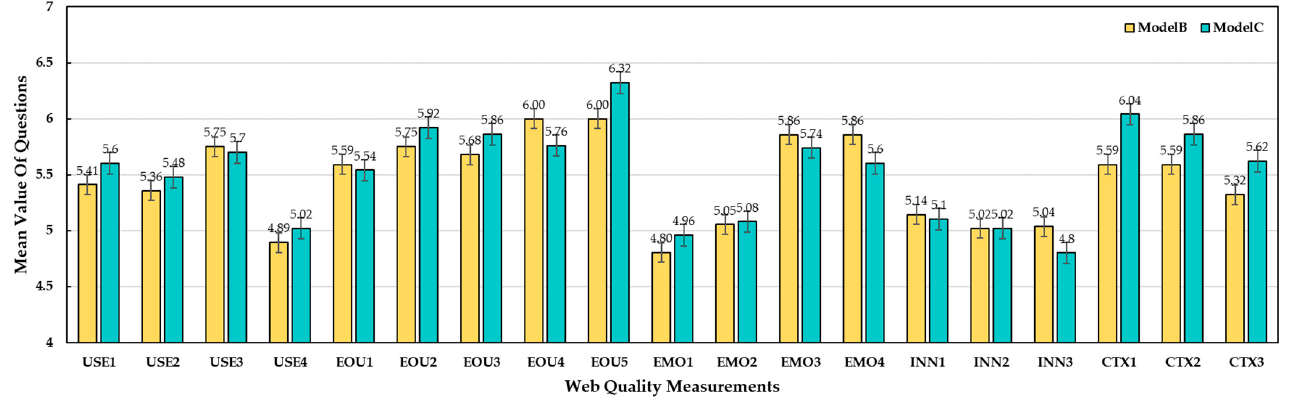
Figure 6. Comparison of user attitudes and user intentions between Model A and Model C.